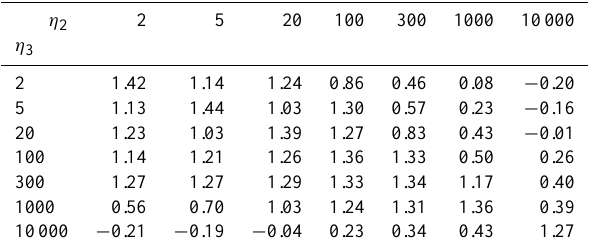
Table A1. Tangent of the slope of the curve showing the dependence of the logarithm of L 2 -error for pressure P on the logarithm of the grid step for different viscosity contrasts. Linearly varying viscosity.